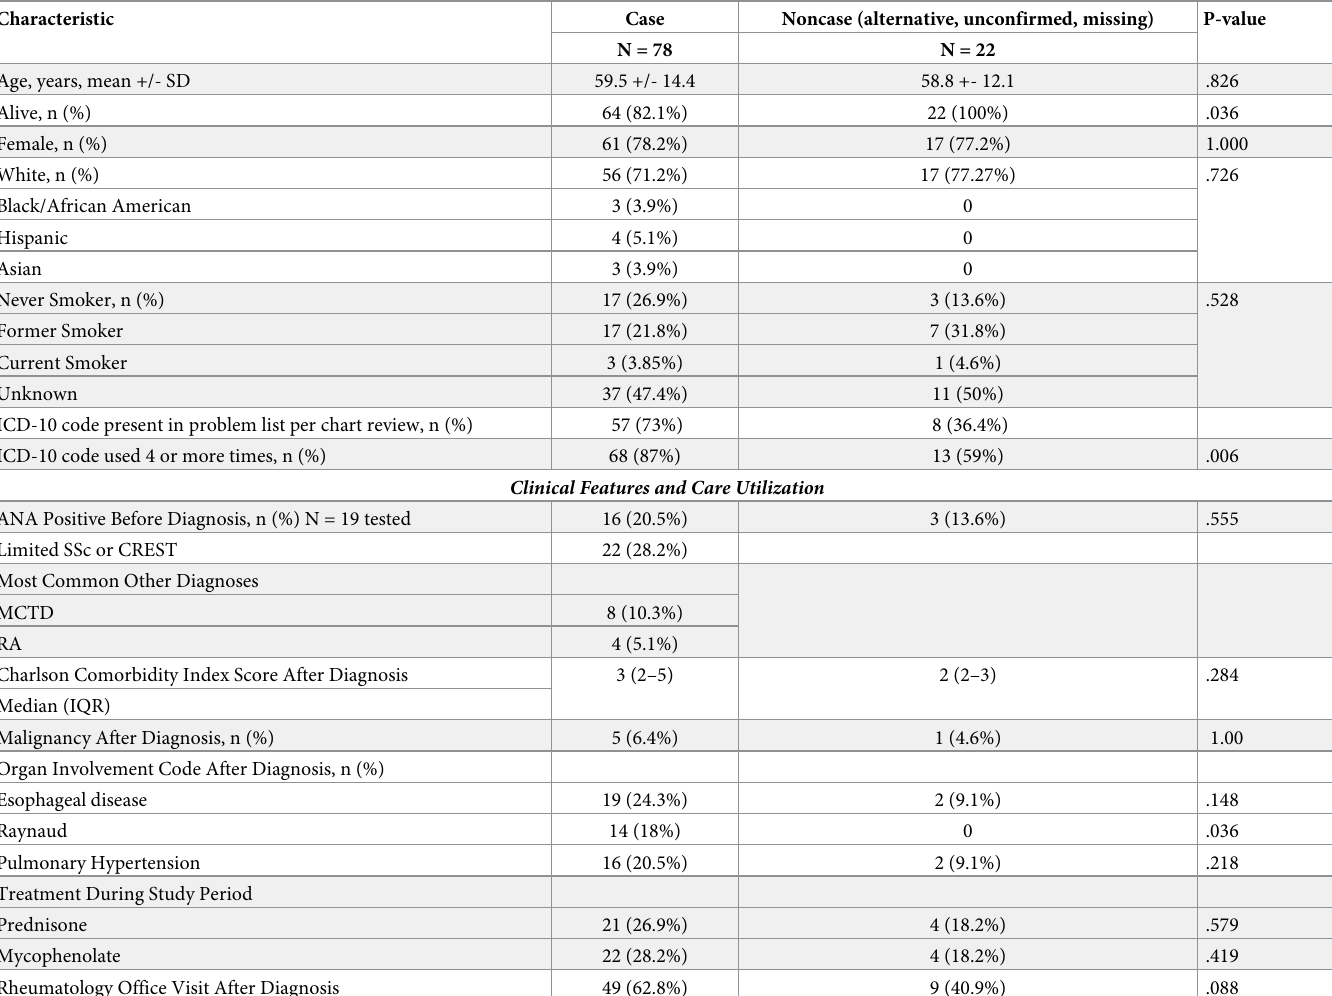
Table 2. Characteristics of patients based on case classification N = 100 (baseline validation